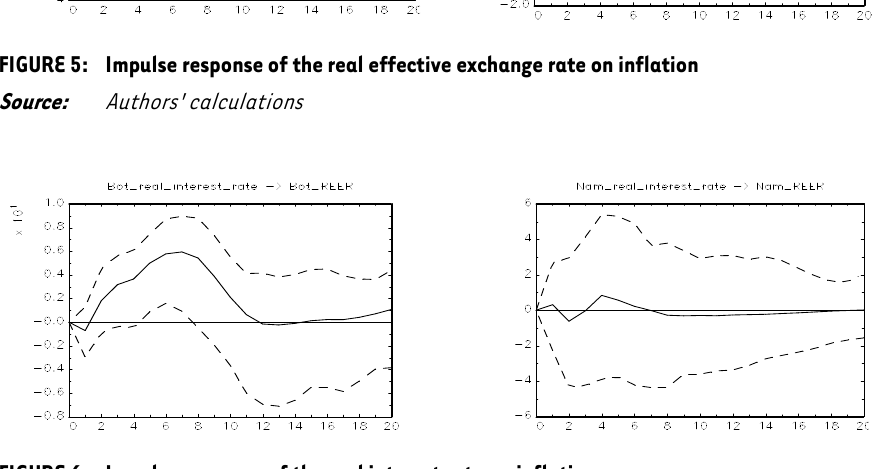
FIGURE 6: Impulse response of the real interest rate on inflation Source: Authors' calculations